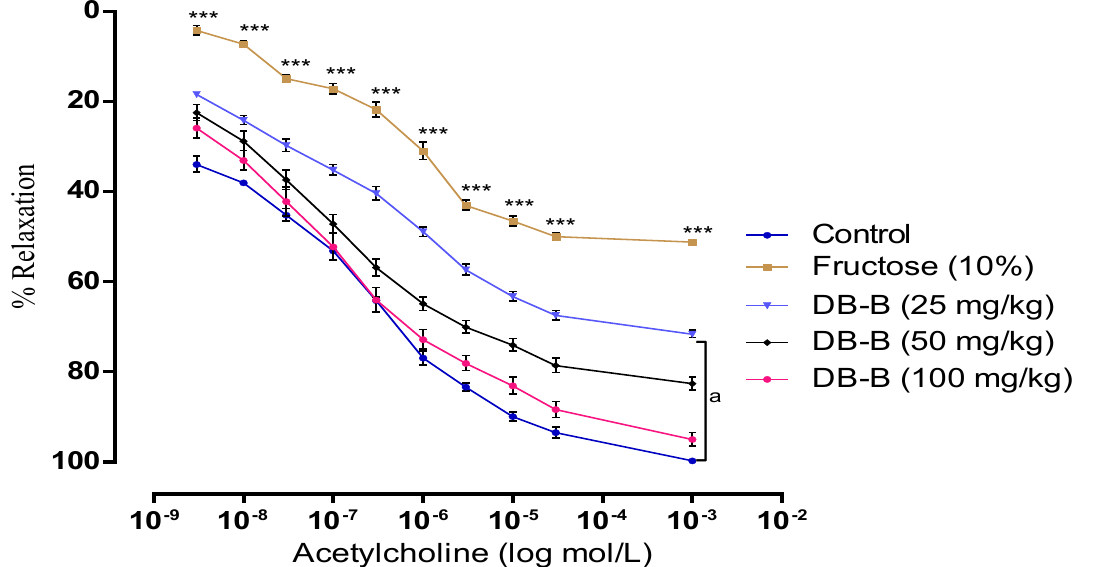
Figure 9. DB-B-mediated reversal of acetylcholine-evoked vasorelaxation in PE preconstricted aortic tissues. Data obtained was analyzed statistically using two-way ANOVA followed by the Bonferrani test on GraphPad Prism. Here, each point represents the mean ± SEM of n = 5. *** represents p < 0.001 in comparison with the control group, whereas a = p < 0.001 with respect to the fructose (10%) group. DB-B = butanolic fraction of D. brunonianum.